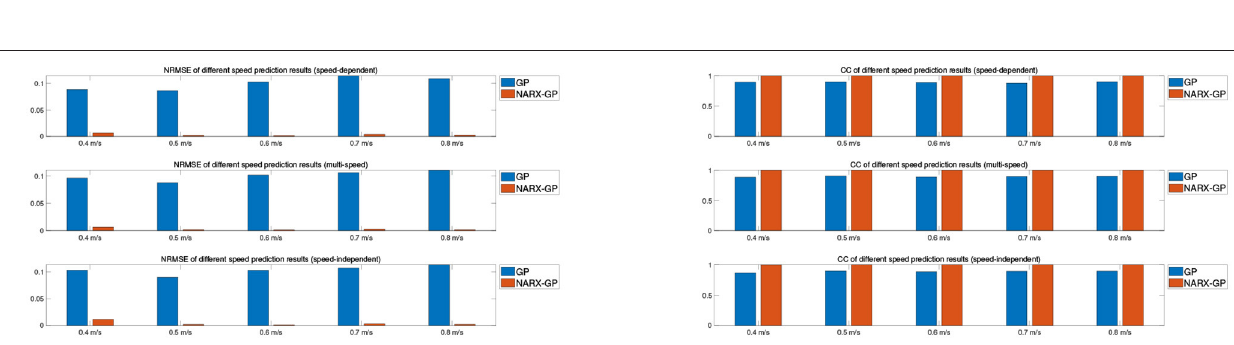
FIGURE 15 | Angle prediction results of NARX-GP model and GP model for hemiplegic subject